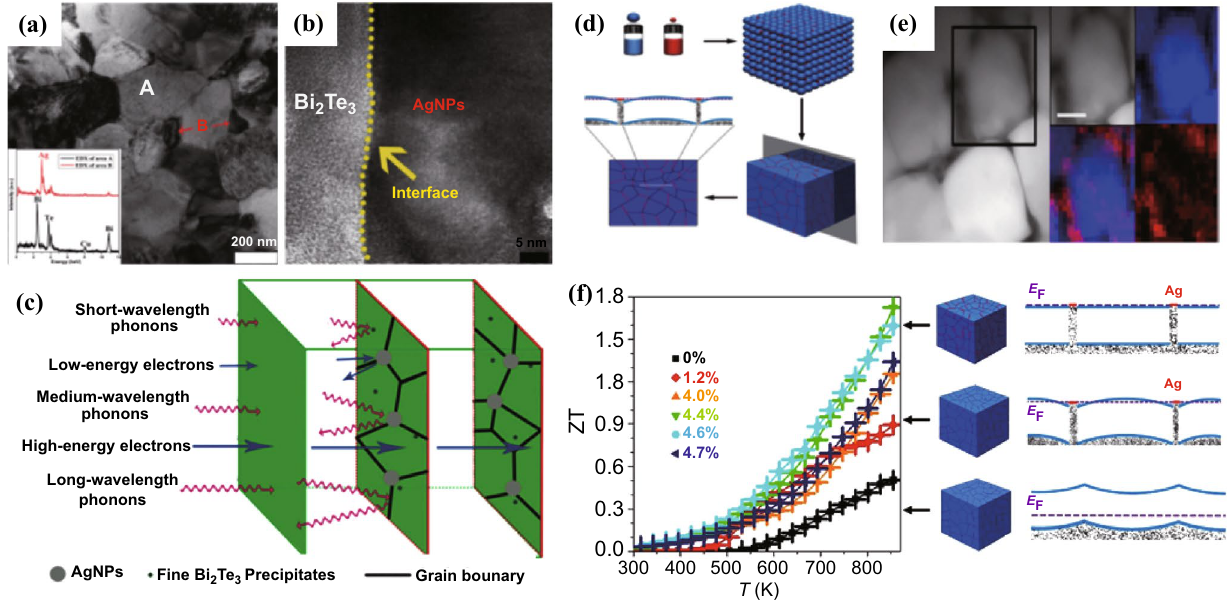
Fig. 7 a Low magnification TEM image of the bulk Bi 2 Te 3 nanocomposite with 5.0 vol% AgNPs nanocomposites. b HRTEM image showing the newly-built interface between the Bi 2 Te 3 matrix and AgNPs. c Schematic drawing of a hierarchical two-phased heterostructure, showing the strong scattering of phonons with multiscale mean free paths along with the energy filtering effect. d Bottom-up assembly process to produce PbS–Ag TE nanocomposites from the assembly of PbS (blue) and Ag (red) NCs, and the corresponding band alignment of the resulting nano- composite. e HRTEM and elemental EDX mapping of the PbS–Ag 4.4 mol% nanocomposite. f Figure of merit and schematic representation of the electron energy band alignment in PbS–Ag nanocomposite. Adapted with permission from Refs. [108, 109]. (Color figure